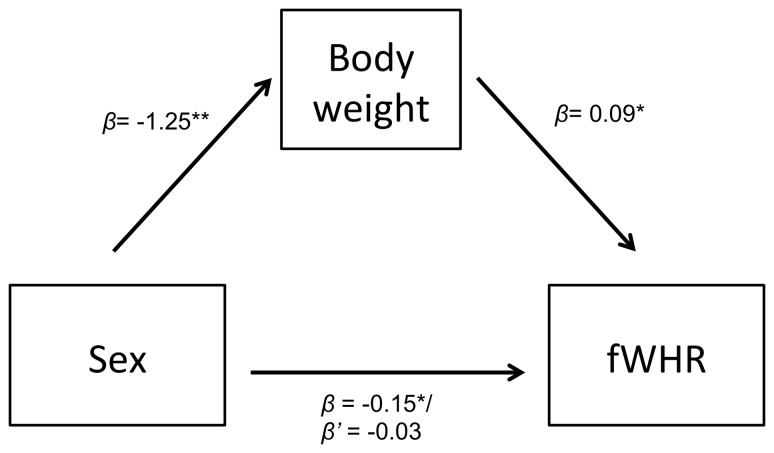
Mediation model of sex differences in fWHR by weight.